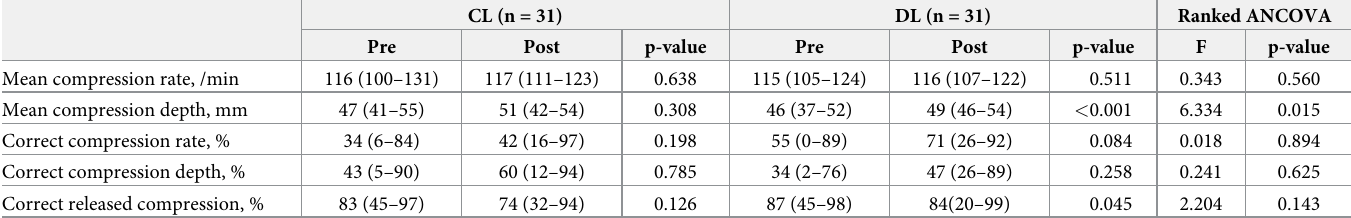
Table 3. Comparing the compression parameters before and after the training according to learning methods.